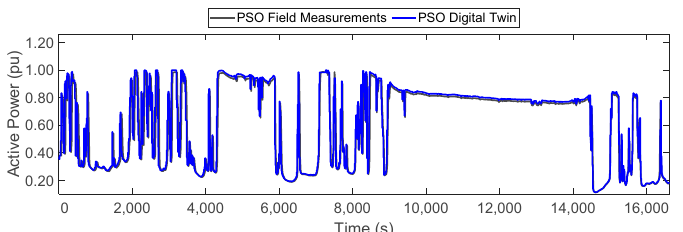
Figure 14. Comparison Between the Digital Twin and the Field Demonstration Active Powers.